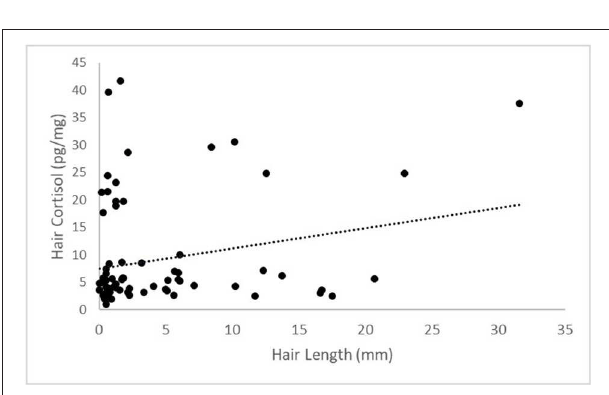
FIGURE 4 | A scatterplot between base 10 logarithm transformed values for hair cortisol and hair length. A weak, positive correlation of r = 0.33 with a P -value =